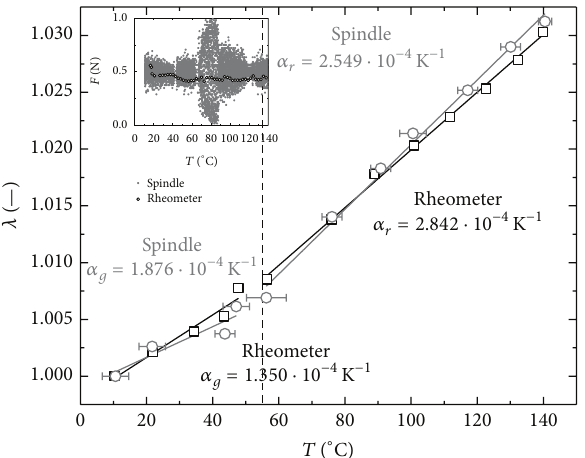
Figure 1: Thermal expansion during heating while applying con- stant tensile force of 0.5